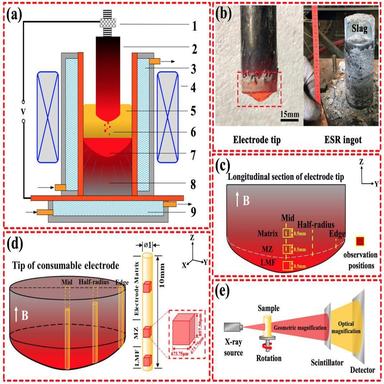
(a) Schematic diagram of the remelting apparatus (1 mechanical apparatus, 2 consumable electrode, 3 water-cooled mold, 4 MF generator, 5 slag pool, 6 droplets, 7 metal pool, 8 ESR ingot, 9 water-cooled baseplate), (b) The obtained electrode tip and ESR ingot, (c) Schematic diagram of sampling method for macro/micro-structure and inclusion detection (type) in electrode tip, (d) Schematic diagram of sampling method for 3D characterization of inclusion in electrode tip, (e) Schematic diagram of the 3D X-ray ex